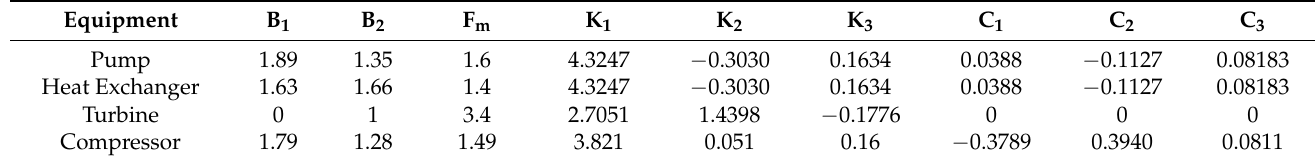
Table 3. Detailed description of the economic assessment